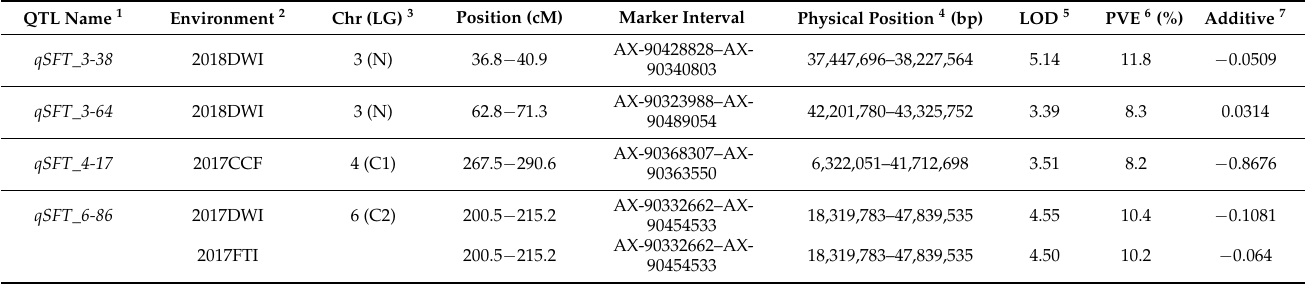
Figure 1. Frequency distribution of leaf chlorophyll content (CC, SPAD value) and shoot dry weight (DW, g) of 152 recombi- nant inbred lines (RILs) under control and flooded conditions over two years. ( a – c ) CC in 2017, 2018, and mean of two years under the control; ( d – f ) CC in 2017, 2018, and mean of two years under flooding; ( g – i ) DW in 2017, 2018, and mean of two years under control; ( j – l ) DW in 2017, 2018, and mean of two years under flooding conditions, respectively. Table 3. Flooding tolerance-related QTL identified in a recombinant inbred line population derived from ‘Danbaekkong’ ×